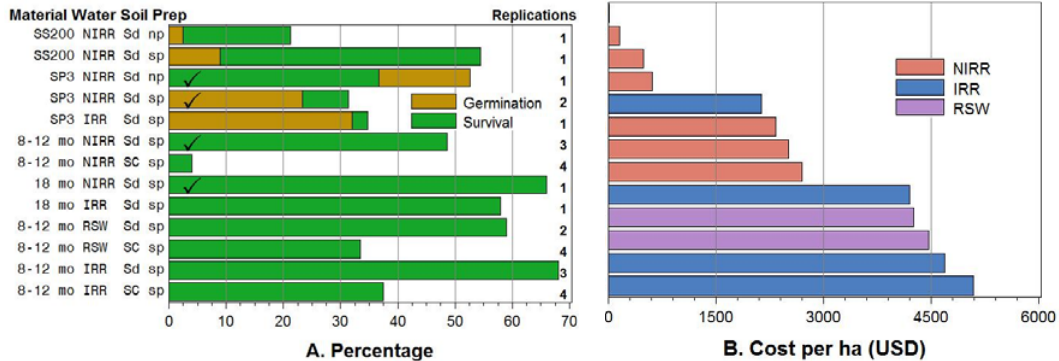
Figure 8. ( A ) Stone pine ( Pinus pinea ) percent survival (and germination for seed